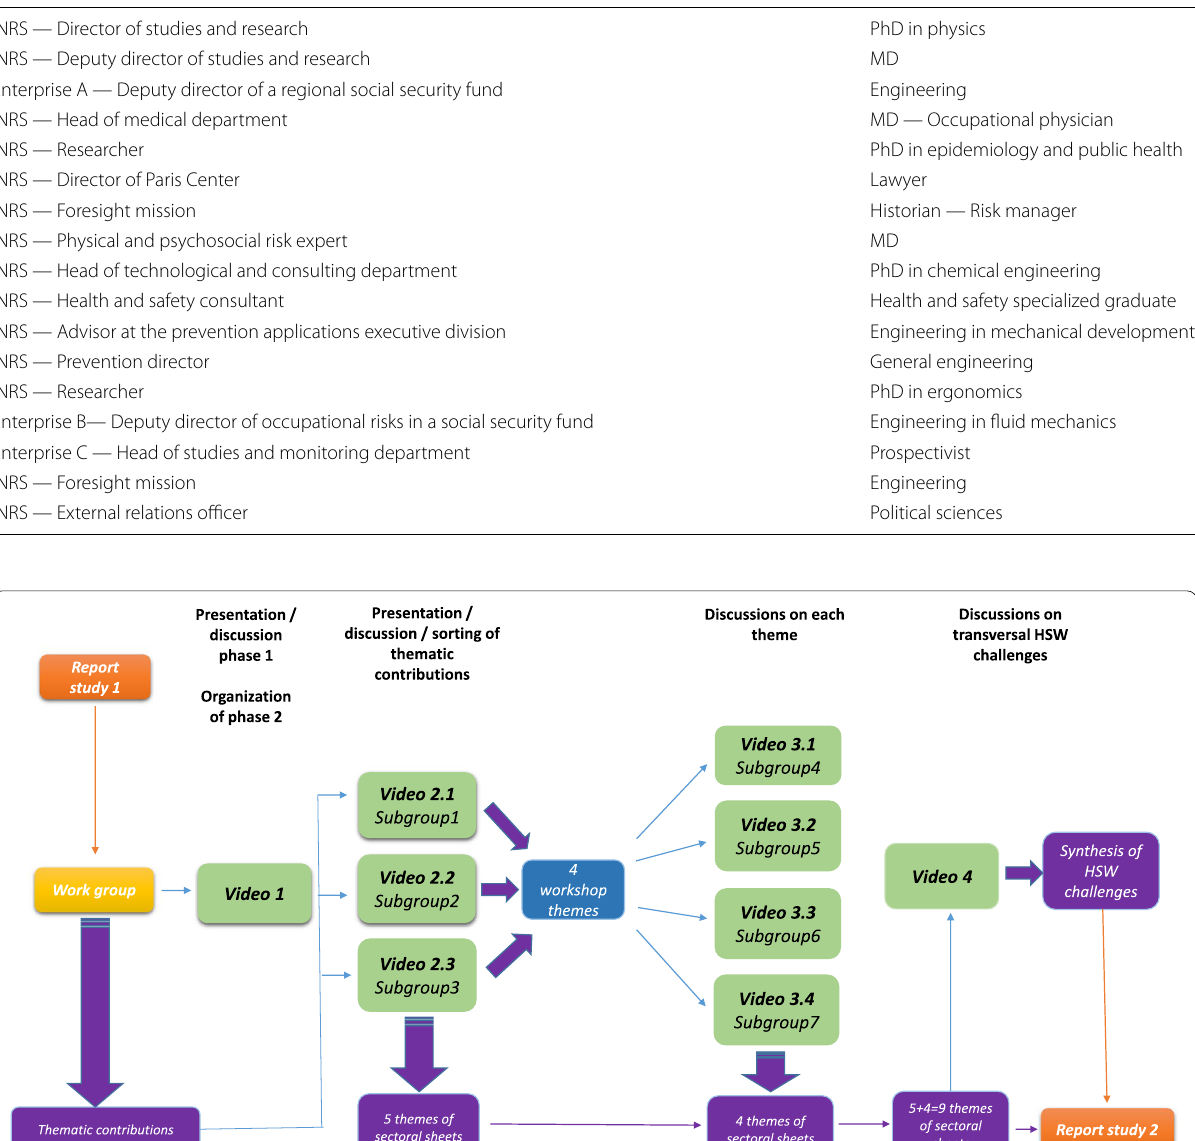
Table 1 Field of expertise of the experts involved in the second study (determining the evolution of occupational and safety risks) Current position